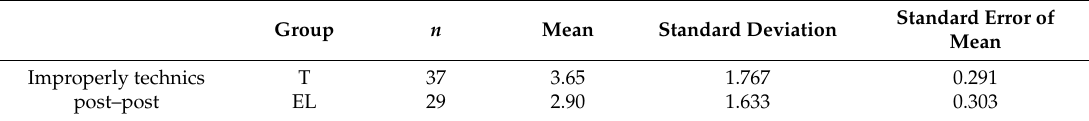
Table 8. Descriptive statistics of the post–post technical skills test improperly executed.